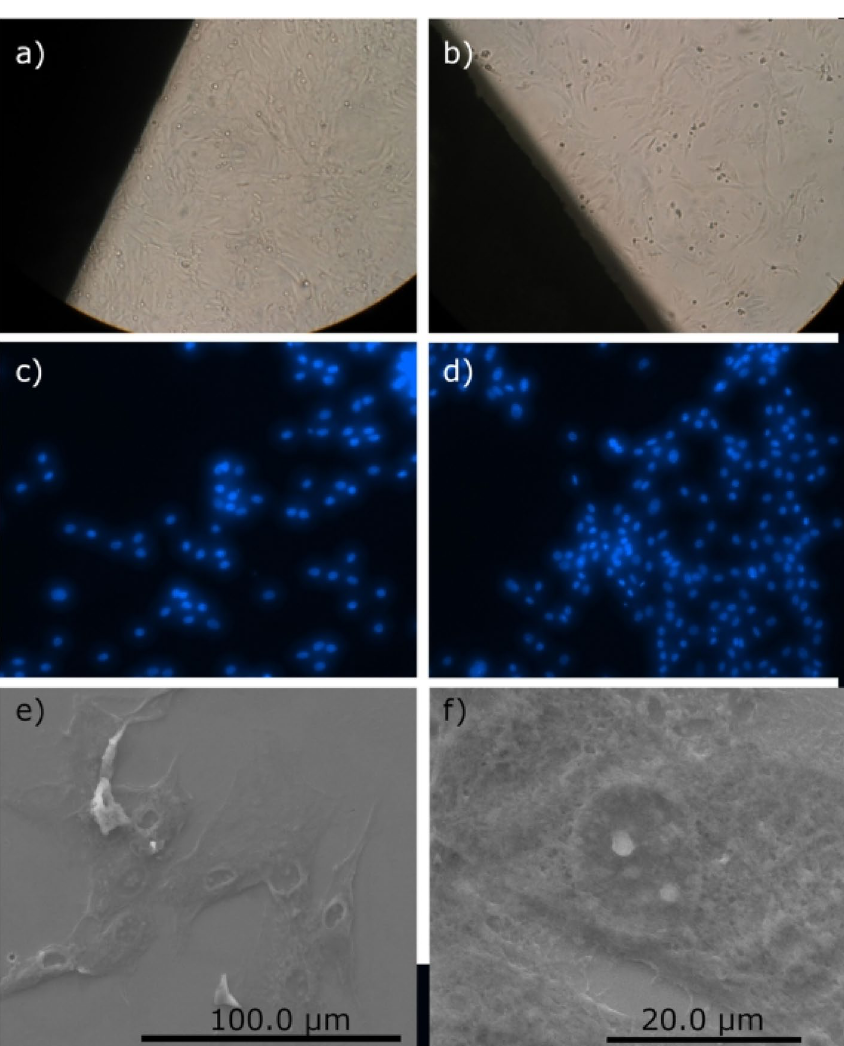
Figure 20. Optical micrograph of the proliferation of osteoblast primary ( a ) uncoated AISI 316L and ( b ) ZrO 2 - ZrO x N y -316L system at 72 h. Images of fluorescence microscopy ( c ) uncoated AISI 316L and ( d ) ZrO 2 -ZrO x N y - 316L system at 72 h with a filter; ( e ) and ( f ) culture cells derived from the mouse cranial vault C57BL/6 at 24 h on ZrO 2 -ZrO x N y -316L